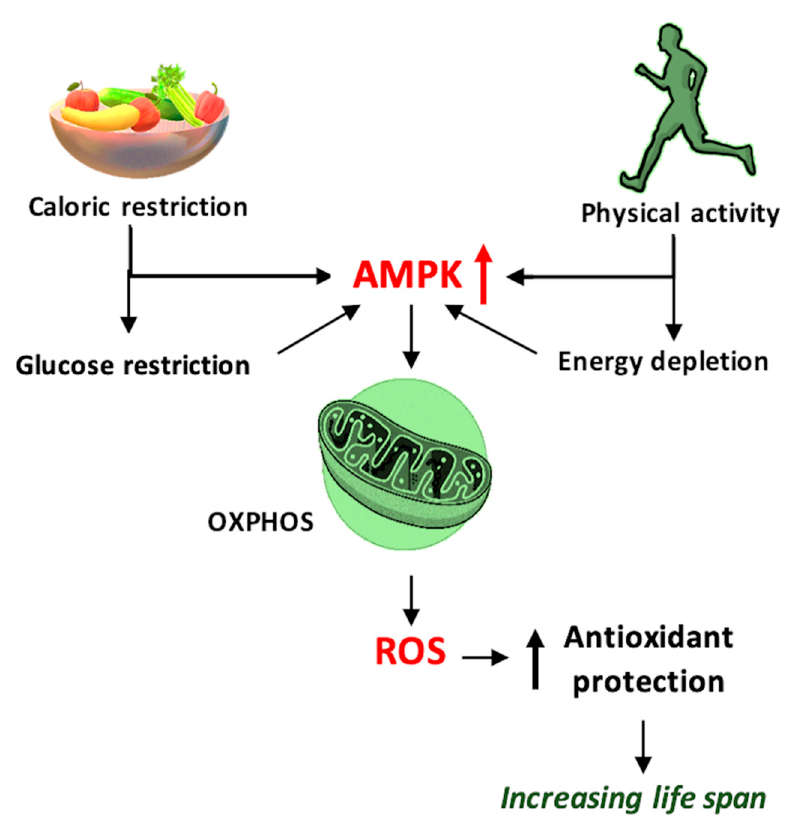
Figure 3. Schematic representation of the mechanism by which caloric restriction and physical activity prolong the lifespan and improve health, using 5 ′ adenosine monophosphate-activated protein kinase (AMPK) and reactive oxygen species (ROS) as mediators, and ROS generated through oxidative phosphorylation (OXPHOS)—schematic mechanism.